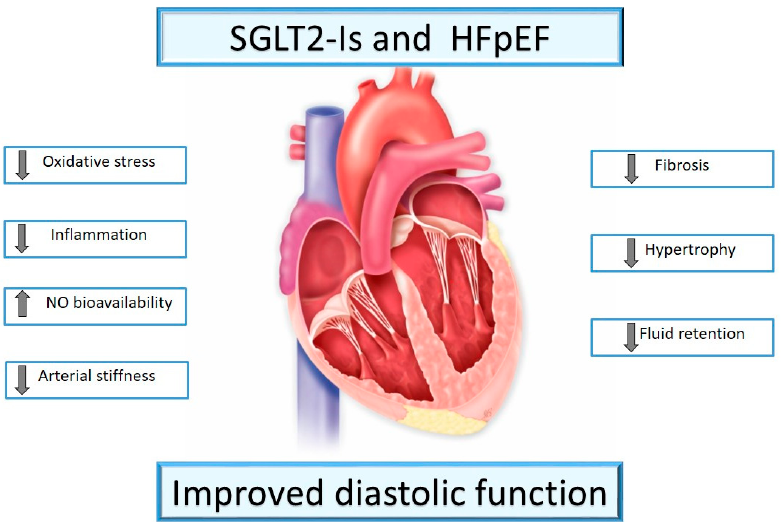
Figure 2. SGLT2-Is and HFpEF. SGLT2-Is improve left ventricular diastolic function. 5. The Rationale for the Use of GLP-1RAs and SGLT2-Is in T2DM Patients with HFpEF Empagliflozin in DM patients with CV disease leads to a reduction in LV mass and LV end-diastolic volume, as well as to an improvement in LV diastolic function after a period of three to six months of therapy [112]. There are several possible mechanisms that may explain SGLT2-Is-induced LV mass reduction. Vasilakou et al. showed that Dapagliflozin could mediate the regression of LV mass by reducing SBP. In fact, there was a statistically significant correlation between the ambulatory reduction of SBP and LV mass reduction that could support this plausible mechanism. It has been observed that SGLT2-Is lead to a reduction of SBP in the range of